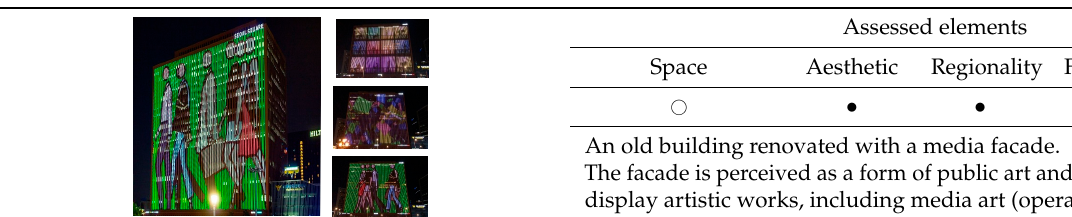
Table 6. Media facades: Seoul Square (Junglim Architecture/iArc 2009).